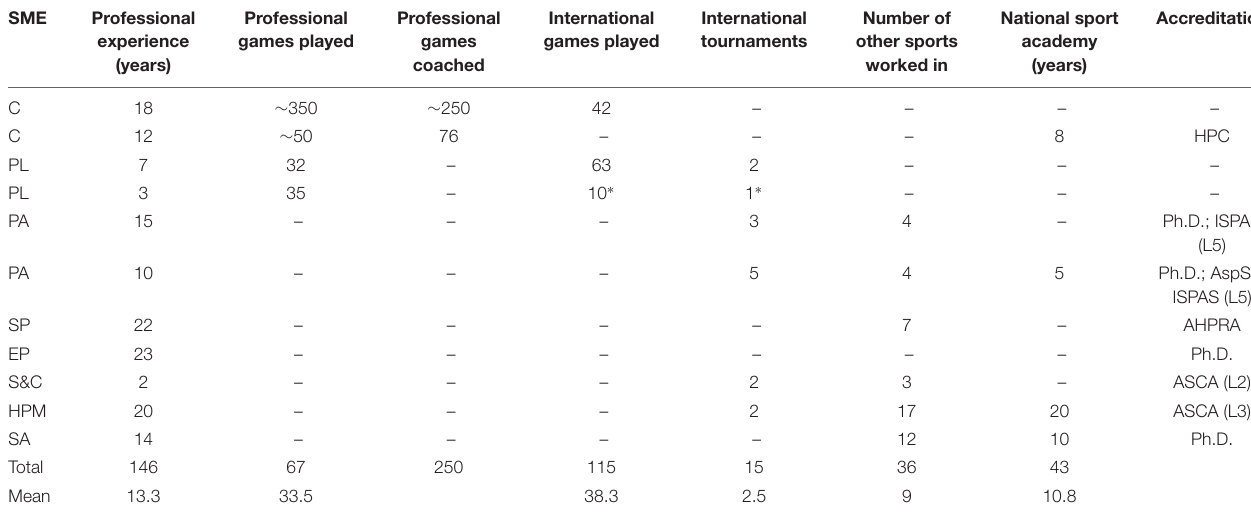
TABLE 1 | Subject matter expert (SME)